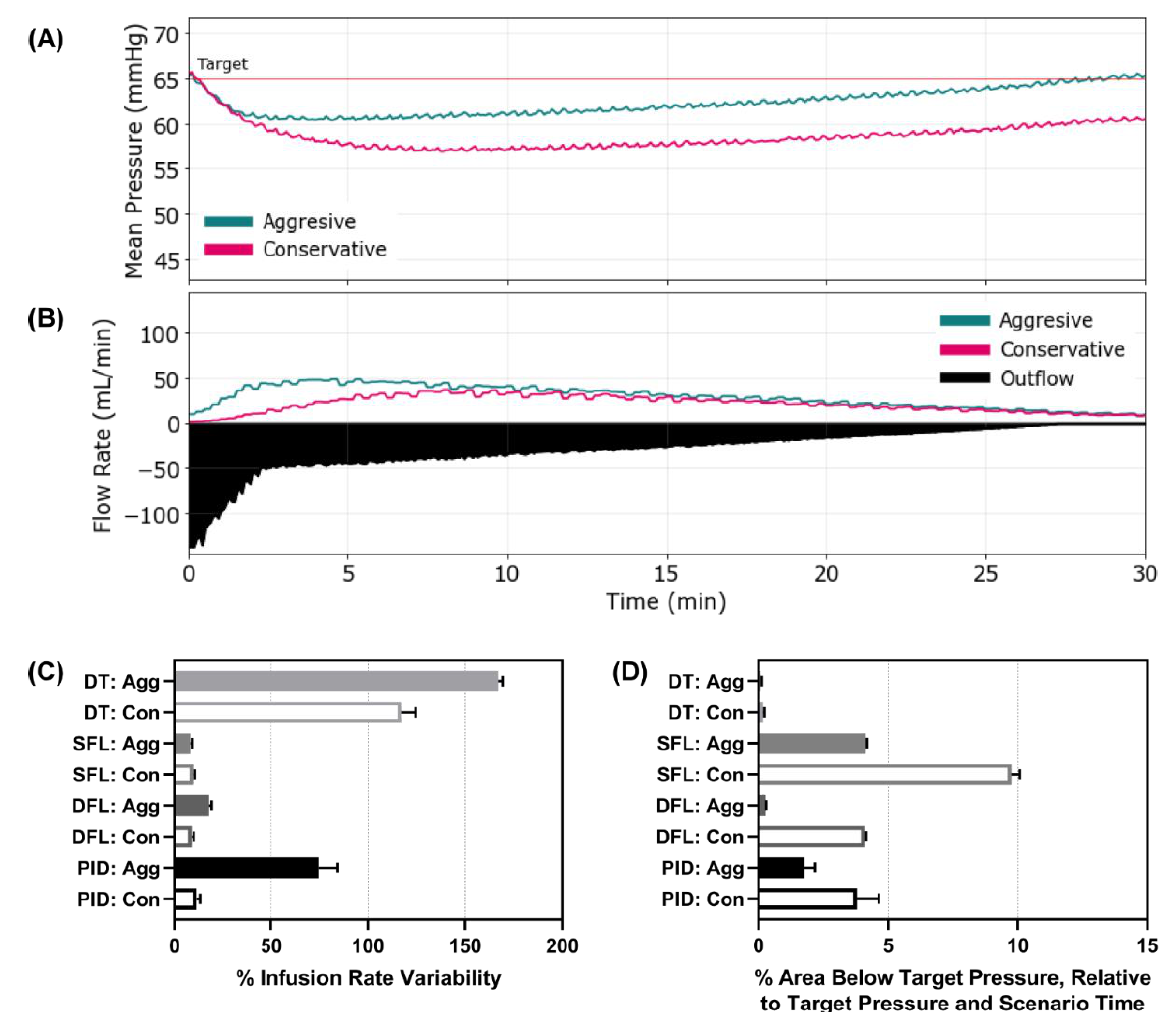
Figure 4. Controller performance for Scenario 2. Representative ( A ) MAP and ( B ) inflow/outflow vs. time for a single run of the aggressive and conservative single-input fuzzy logic controller runs through Scenario 2. Outflow rates are only shown for one controller run. In Scenario 2, MAP begins at a stable 65 mmHg and presents a severe hemorrhage that clots over the 30 min test scenario. Performance results for each controller type (DT = decision table; SFL = single-input fuzzy logic; DFL = dual-input fuzzy logic; PID = proportional–integral–derivative controller) and configuration (Agg = aggressive; Con = conservative) for the ( C ) percent infusion rate variability (lower is better) and ( D ) area below the target pressure metric (lower is better). Average results are shown for three subject variability runs for each. Error bars denote the standard deviation.